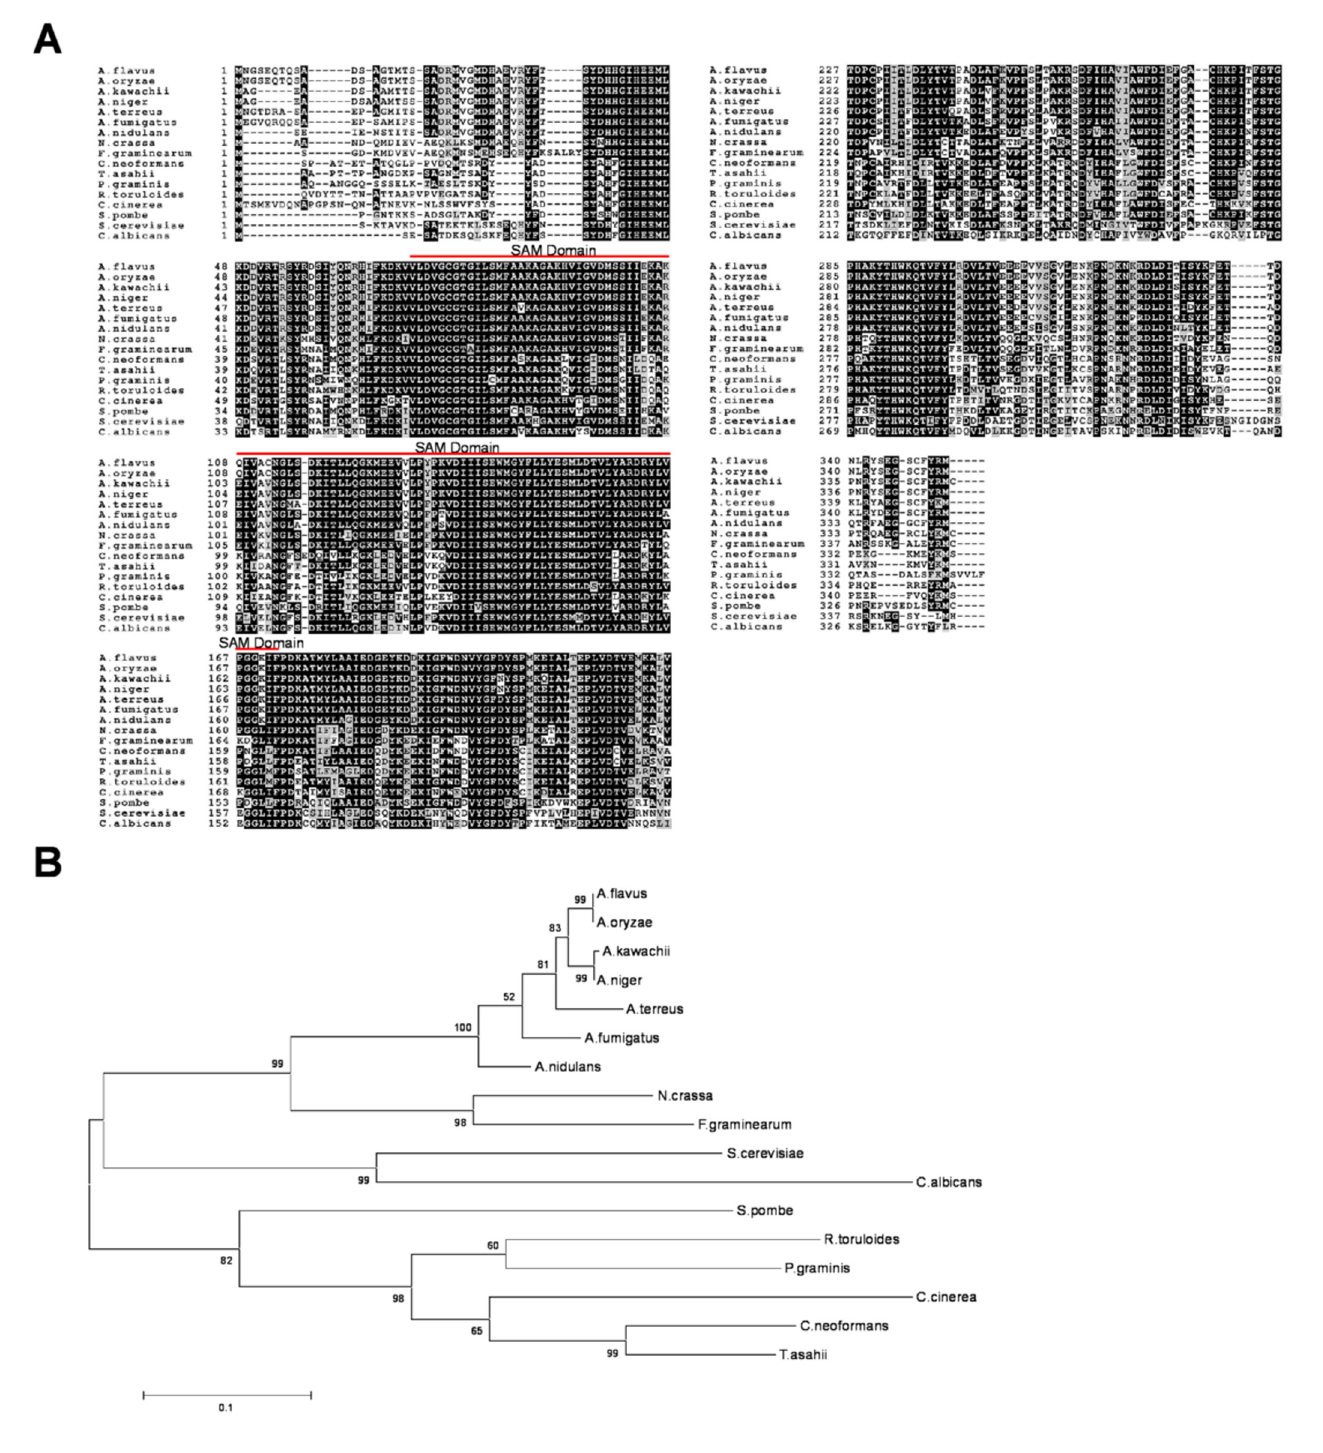
Fig 1. Multiple sequence alignment and phylogenetic analysis of RmtA and other fungal homologs. (A) Sequences aligned using Muscle (http:// www.ebi.ac.uk/Tools/msa/muscle/). Alignment was visualized with BoxShade v3.21 (http://ch.embnet.org/software/BOX_form.html). (B) Phylogenetic tree of RmtA homologs from different fungal species. Phylogenetic trees constructed using MEGA v6.0. Trees were generated with Maximum-Likelihood model with a bootstrap value of 1000.